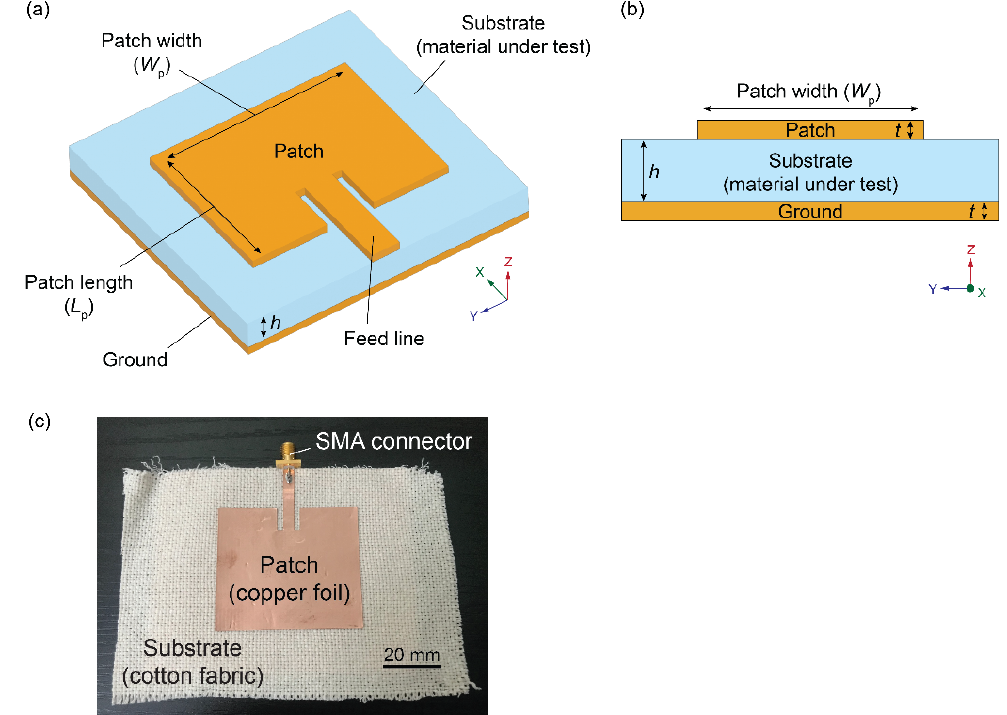
Figure 14. Schematic illustration of a rectangular patch antenna in ( a ) perspective and ( b ) cross- sectional views. Redrawn and simplified from [41] (p. 110); and ( c ) patch antenna sample with an embedded cotton fabric for dielectric characterization. Reprinted with permission from [7] (p. 5).